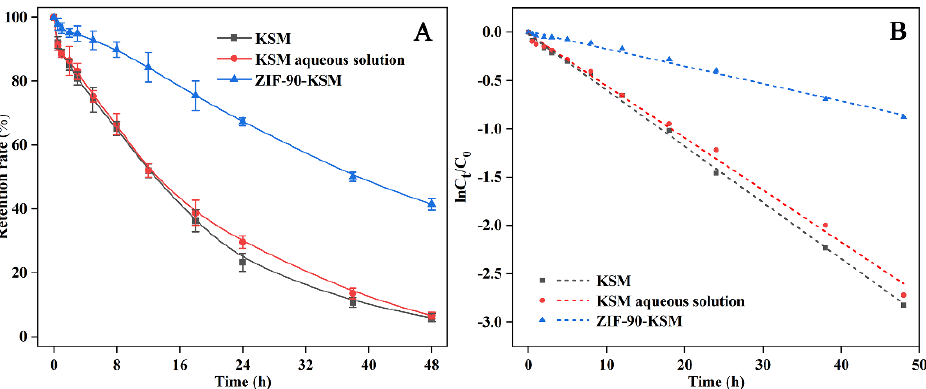
Figure 4. Stability of KSM, KSM aqueous solution and ZIF-90-KSM under ultraviolet radiation ( A ). Pseudo-first-order models of KSM photodegradation for KSM, KSM aqueous solution and ZIF-90-KSM ( B ). Table 1. Modeling parameters for photodegradation of KSM, KSM aqueous solution and ZIF-90- KSM under ultraviolet radiation.